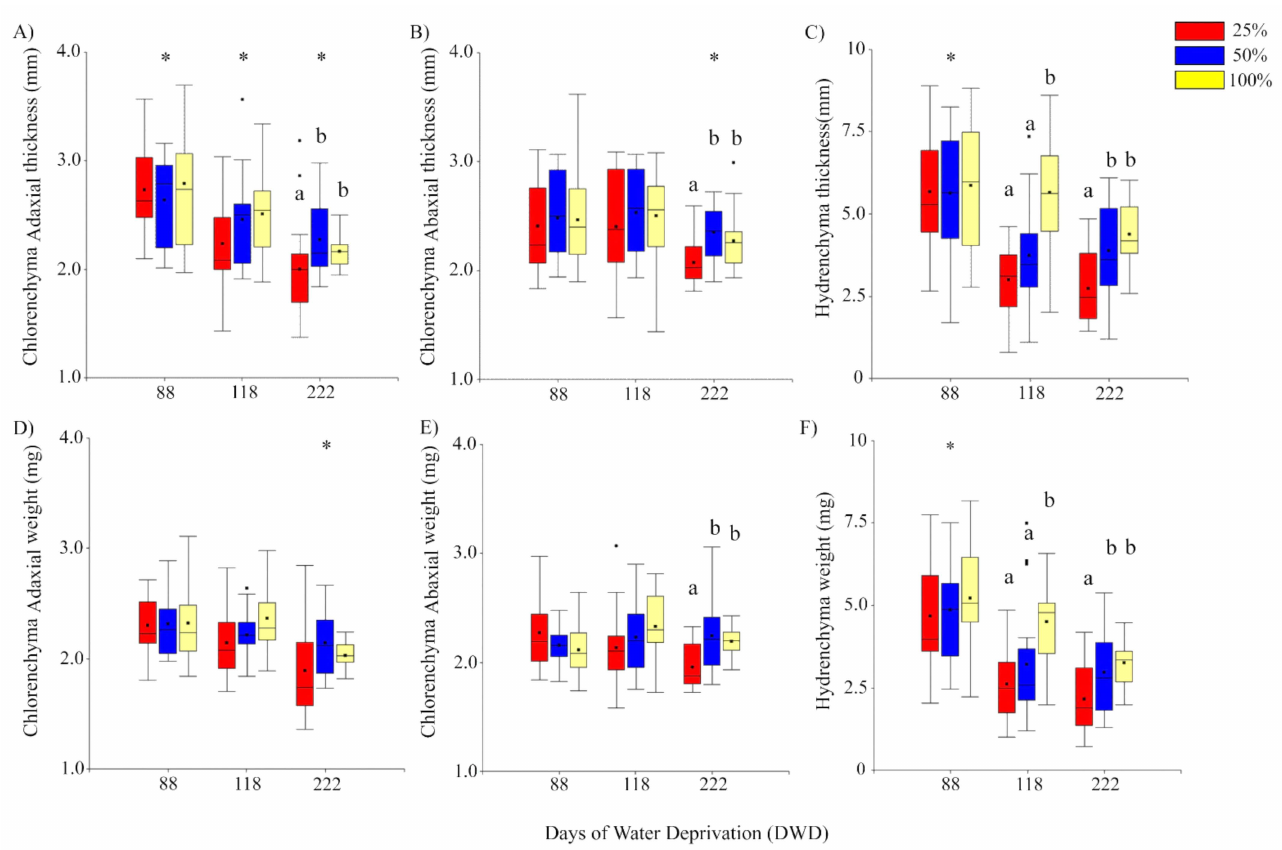
Figure 2. Box plots showing the changes in thickness and weight of the adaxial ( A , D ) and abaxial ( B , E ) portions of the chlorenchyma, and for the central hydrenchyma ( C , F ) in the function of the days with water deprivation (DWD). The central line and black dot within each box represent the average and the median. Vertical lines of the boxes indicate the upper and lower limits. Small dots outside the boxes represent extreme values. Red, blue, and yellow colors represent the values for plants preconditioned at 25, 50, and 100% of field capacity of the soil (% FC), respectively. Asterisk indicates significant differences between DWD at p ≤ 0.05. Different letters indicate significant differences ( p ≤ 0.05) between preconditioning treatments within a given period of water